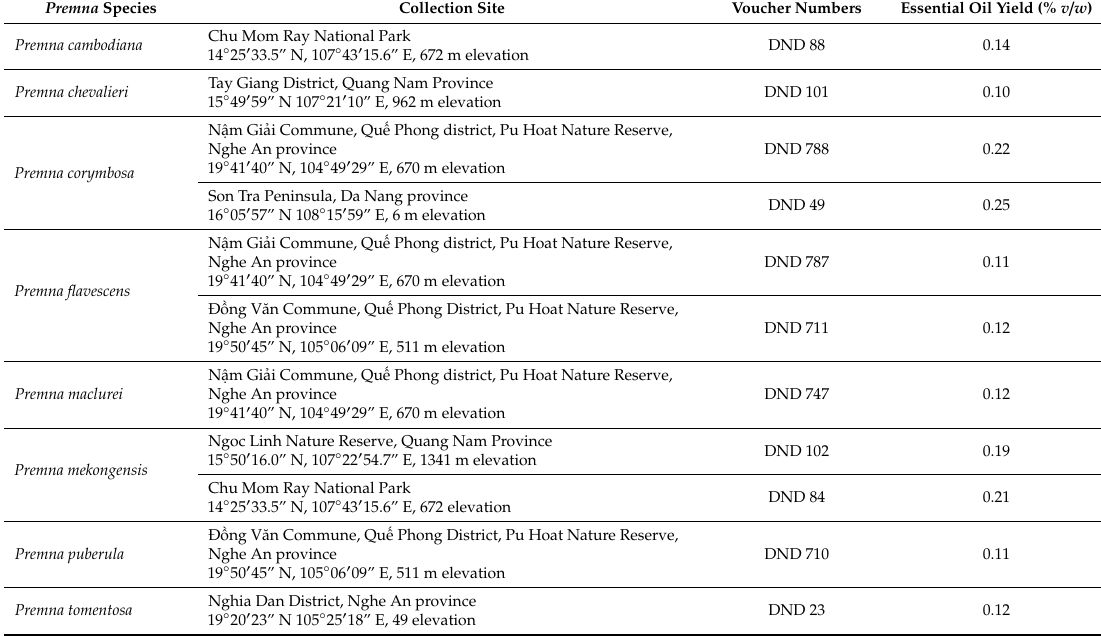
Table 2. Collection details and yields for Premna leaf essential oils from central